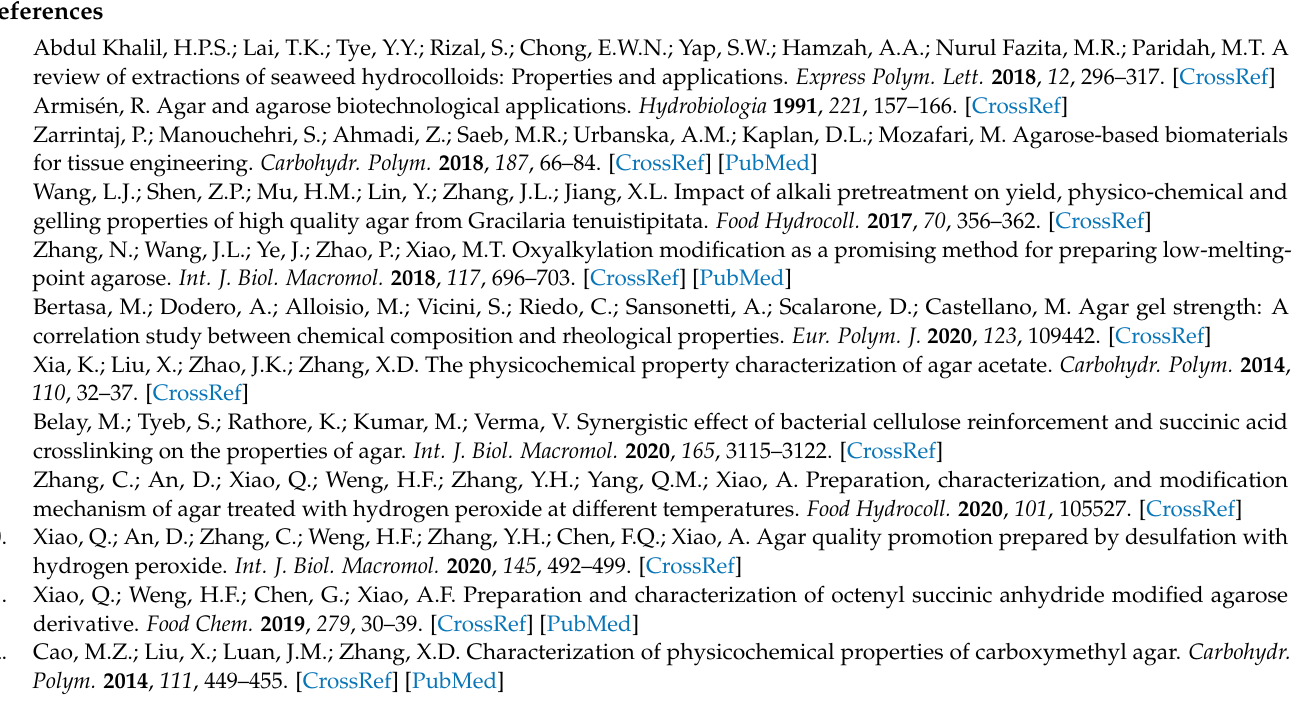
Figure S2: GPC chromatogram of carboxymethyl agar prepared using conventional method with DS of 0.25 (CAg1); Figure S3: GPC chromatogram of carboxymethyl agar prepared using conventional method with DS of 0.47 (CAg2); Figure S4: GPC chromatogram of carboxymethyl agar prepared using microwave-assisted method with DS of 0.25 (MAg1); Figure S5: GPC chromatogram of